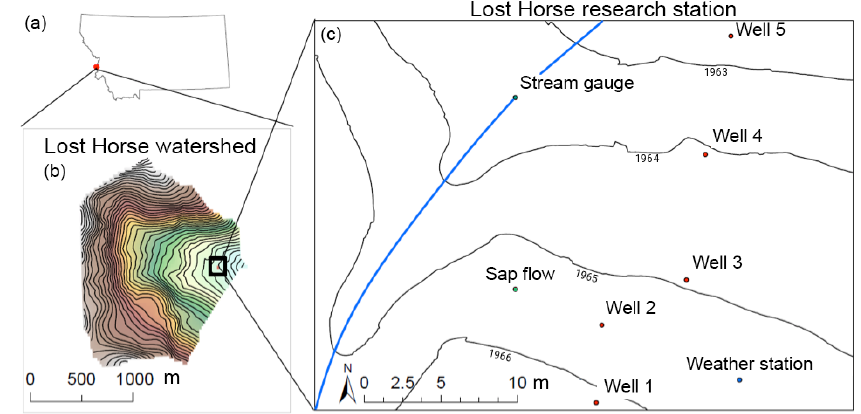
Figure 1. Study area in the upper Lost Horse Creek watershed, including location in western Montana (a) , topography (b) , and instrumenta- tion setup (c)